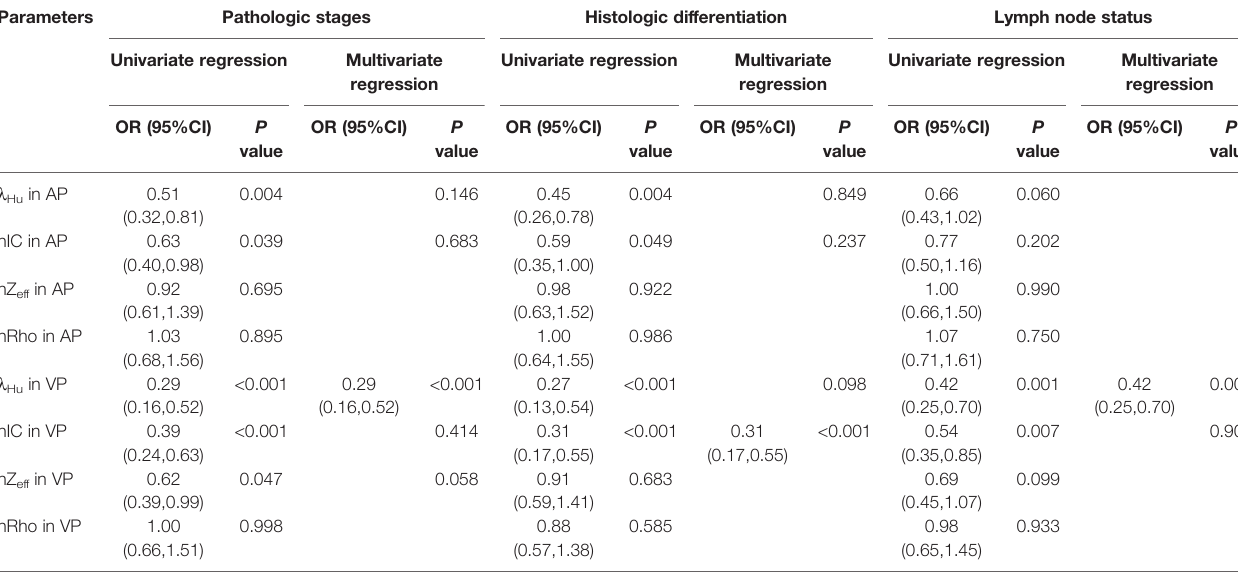
TABLE 3 | Univariate and multivariate logistic analyses of quantitative DECT parameters in predicting the aggressiveness of OTSCC. Parameters